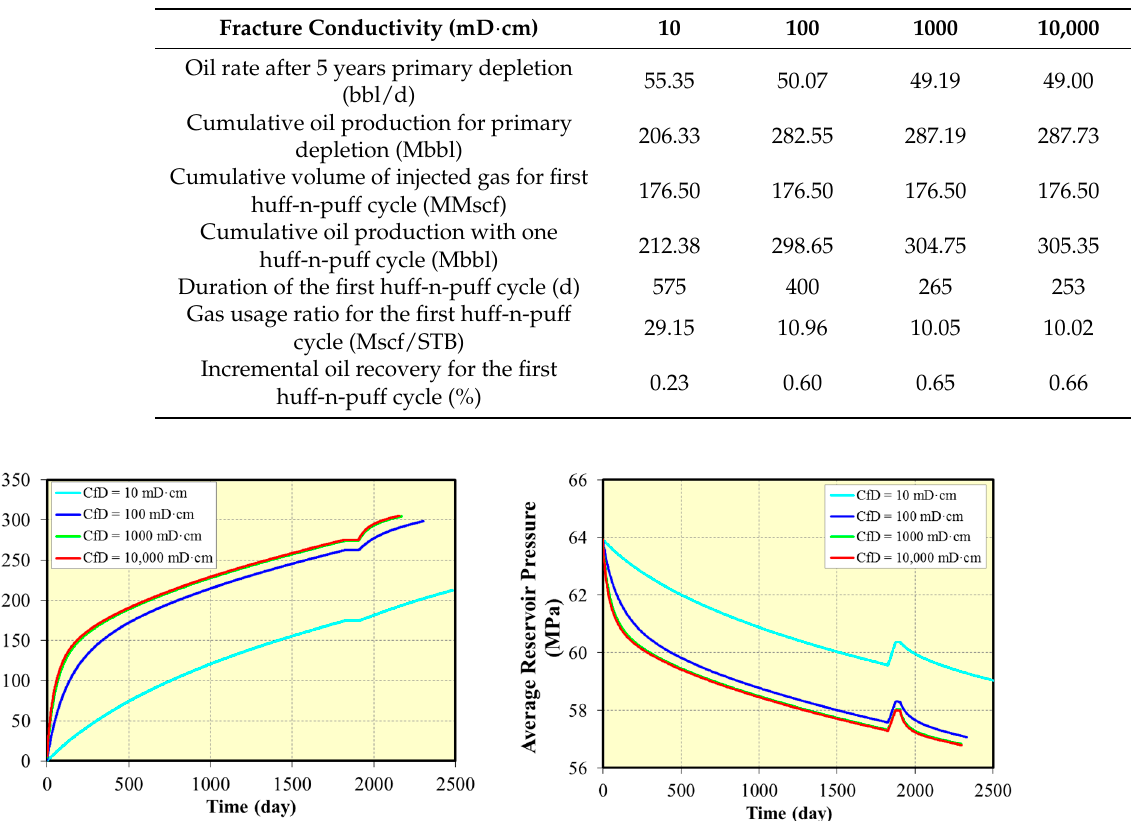
Table 14. Summary of results for huff-n-puff with different fracture conductivity.